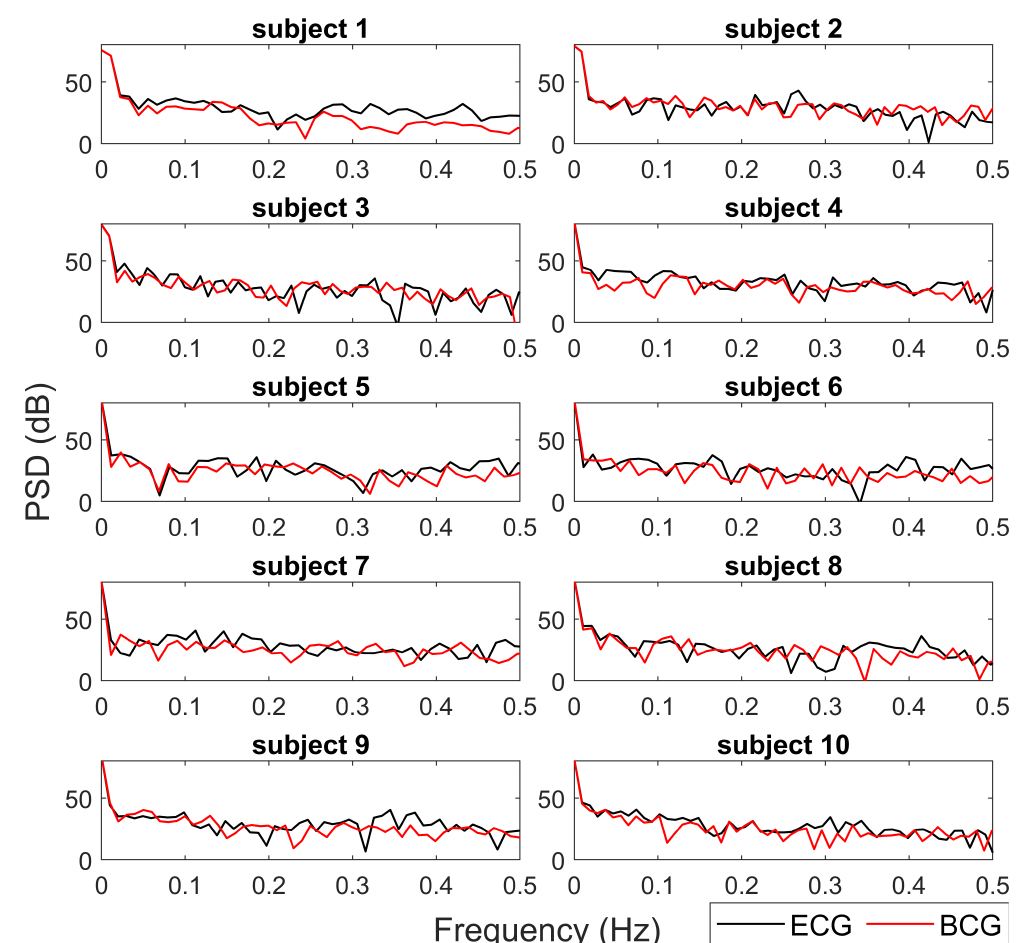
Figure 7. For each subject, the Power Spectrum Densities (PSD) of tachograms from BCG (red lines) and ECG (black lines) are reported. The PSD are expressed in